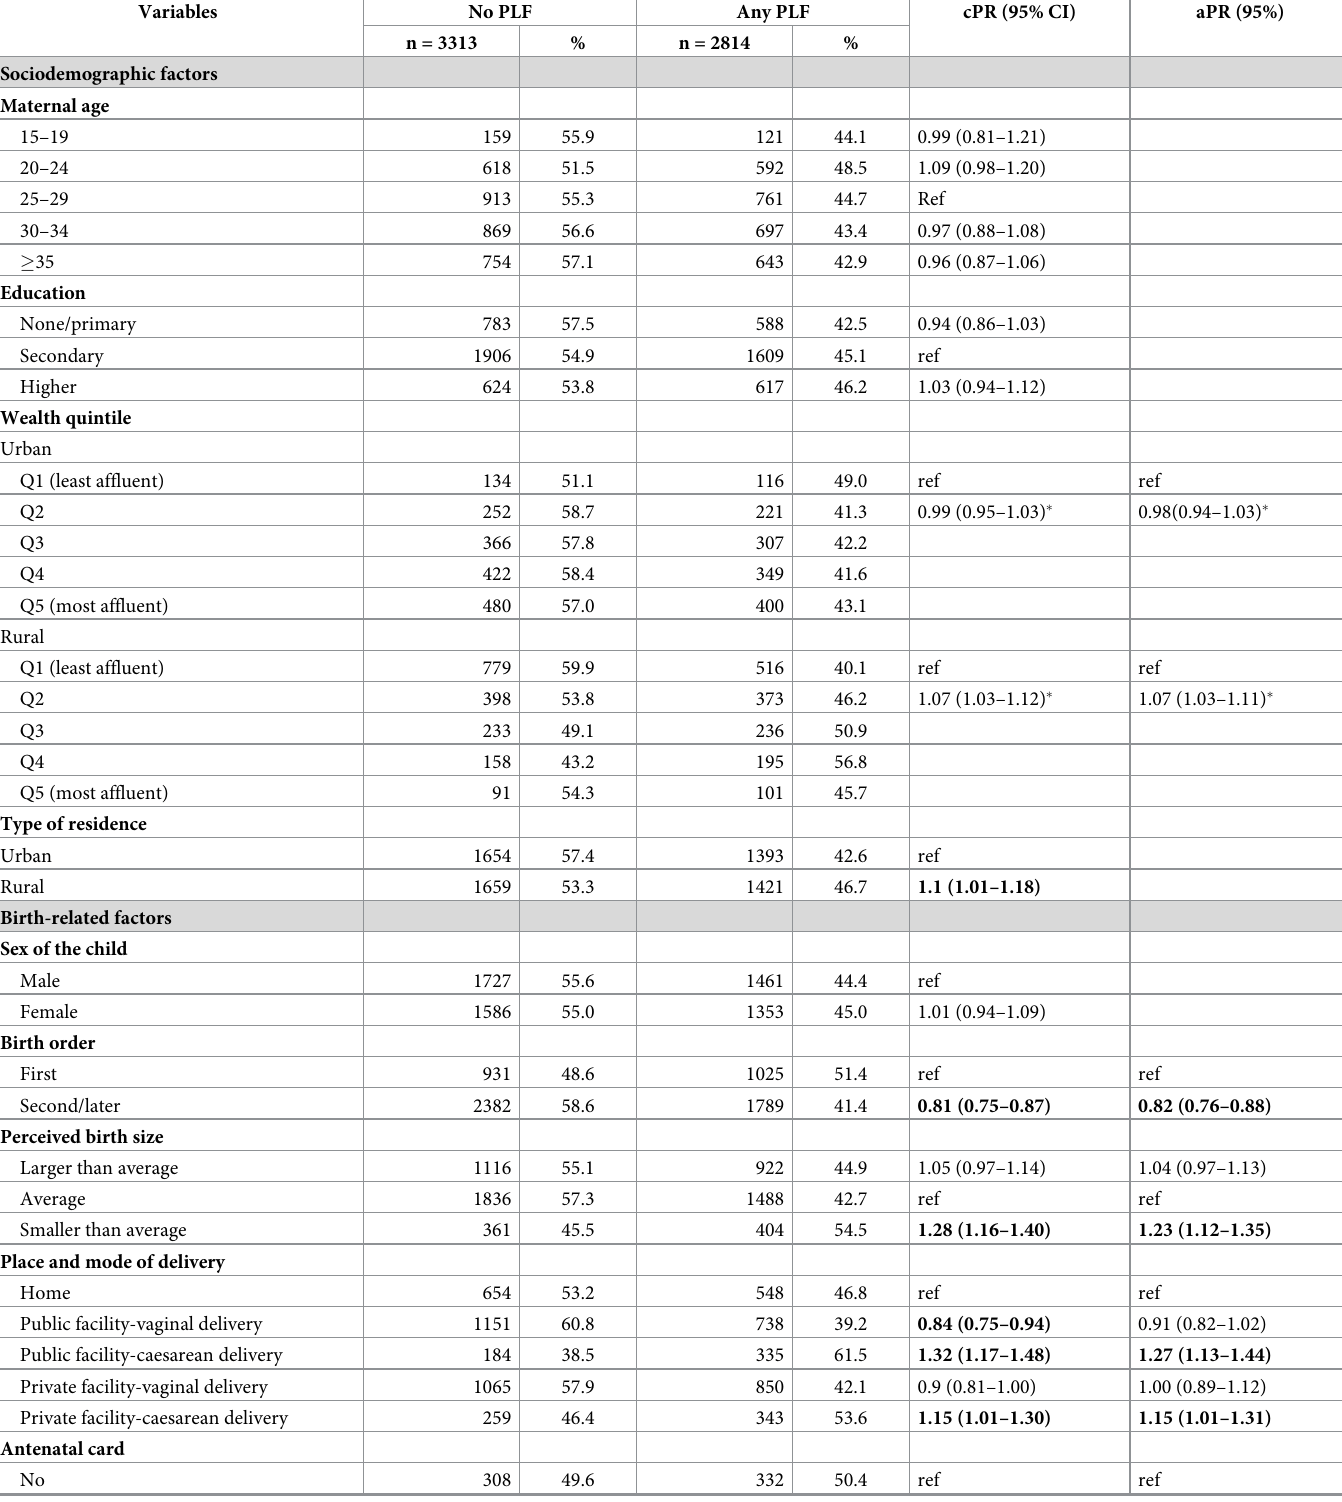
Table 3. Prevalence of any PLF by sociodemographic and birth-related factors and PR (n = 6127).